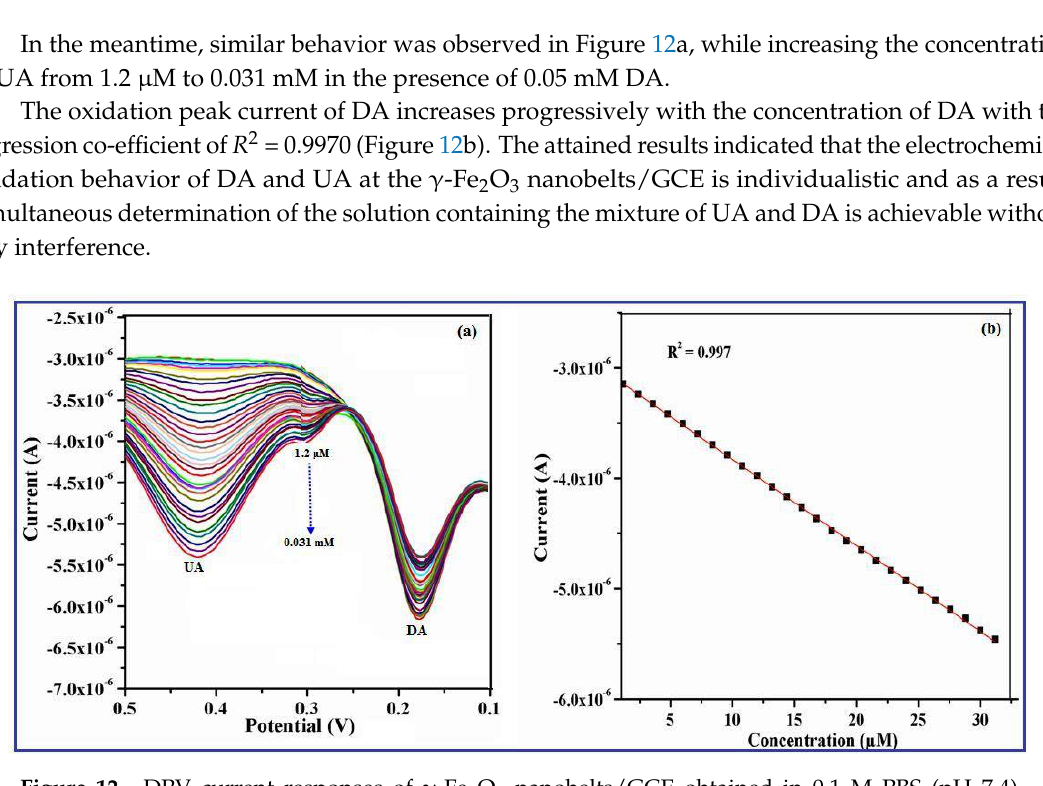
Figure 12. DPV current responses of γ-Fe 2 O 3 nanobelts/GCE obtained in 0.1 M PBS (pH 7.4). ( a ) Various concentration of UA varied linearly from 1.2 µM to 0.031 mM in the presence of 0.05 mM DA ( b ) Calibrations curve of UA plotted versus oxidation current and concentration of UA.